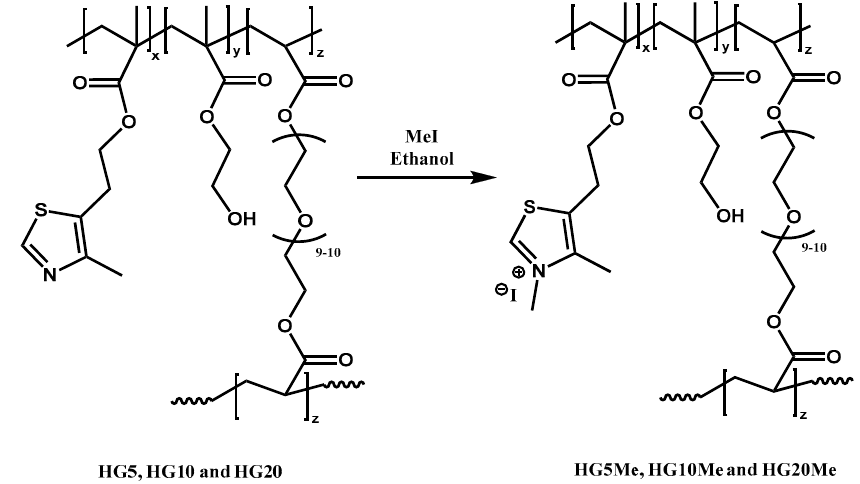
Figure 1. Chemical structure of the unmodified and cationic hydrogels obtained by quaternization reaction.